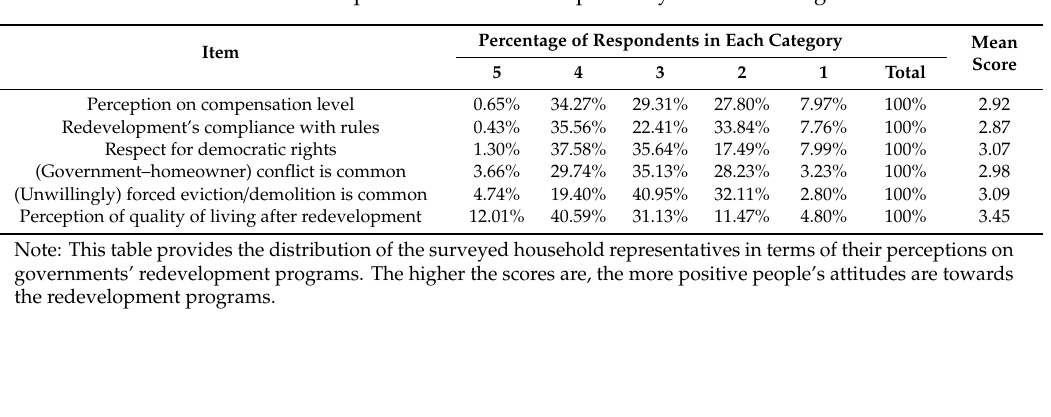
Table 4. Evaluation of Land Acquisition and Redevelopment System and Background